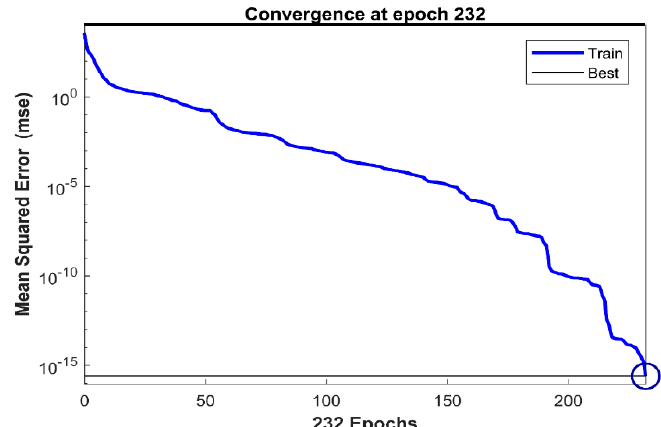
Figure 9. The conversions of the artificial neural network (ANN) training. Figure 9 . The conversions of the artificial neural network (ANN) training. Figure 9 . The conversions of the artificial neural network (ANN) training.